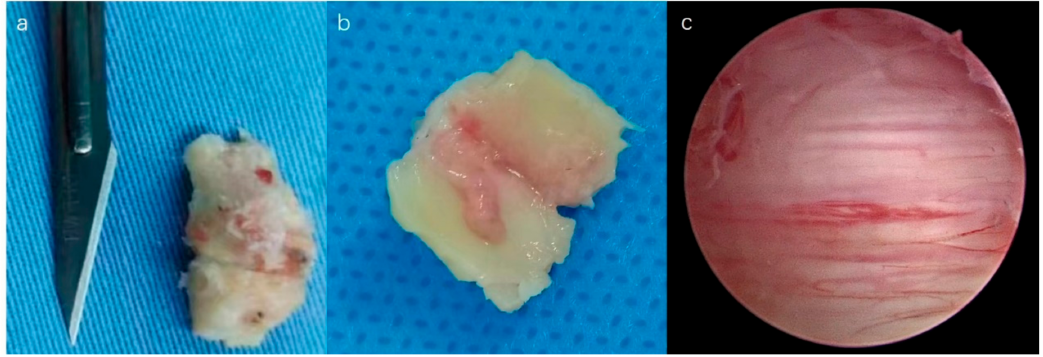
Figure 4. The dorsal and ventral surface of LF ( a , b ). The cord was fully decompressed ( c